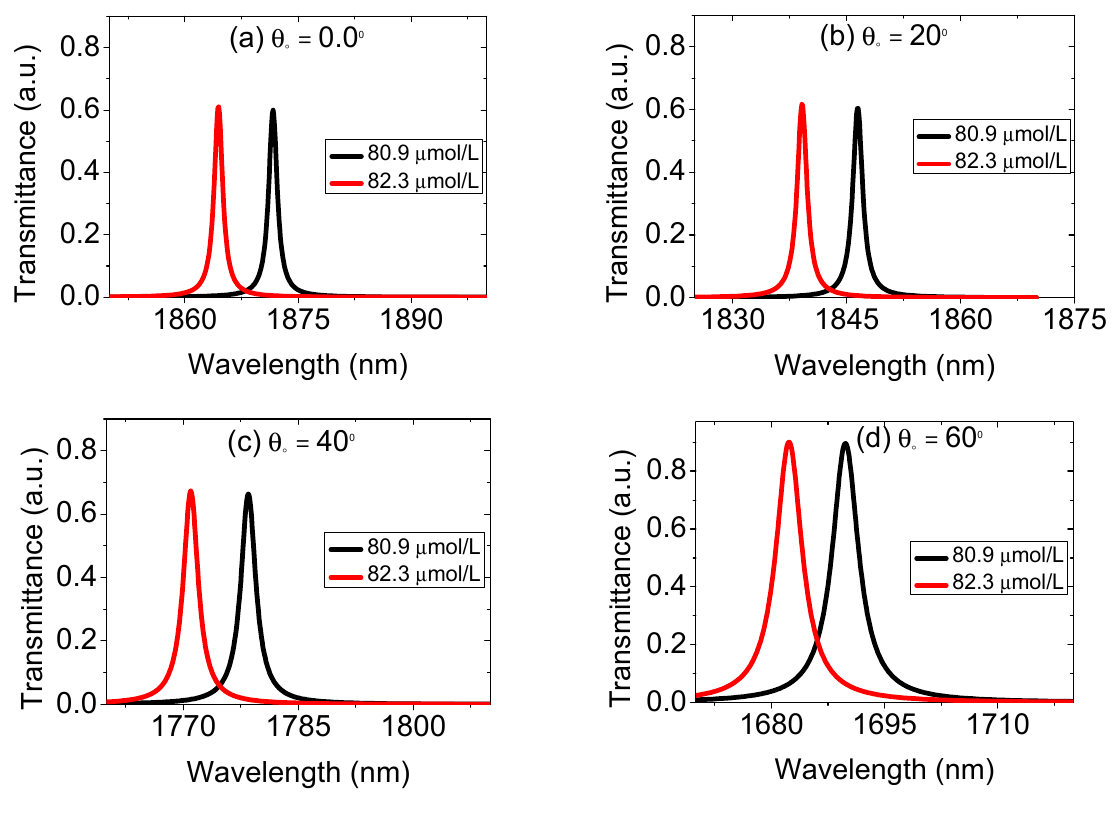
Figure 5. Transmittance curves of the suggested TPC biosensor with different incident angles ( a ) 0.0 ◦ , ( b ) 20 ◦ , ( c ) 40 ◦ , and ( d ) 60 ◦ for the TM mode. Table 3. Position of resonant peak and sensitivity ( S ) of creatinine concentration for different incident angles at n 1 = 3.3, n 2 = 1.28, n 3 = 1.46, h 1 = 120 nm, h 2 = 190 nm, h 3 = 260 nm, h f = 500 nm, and N = 4 (TM mode).